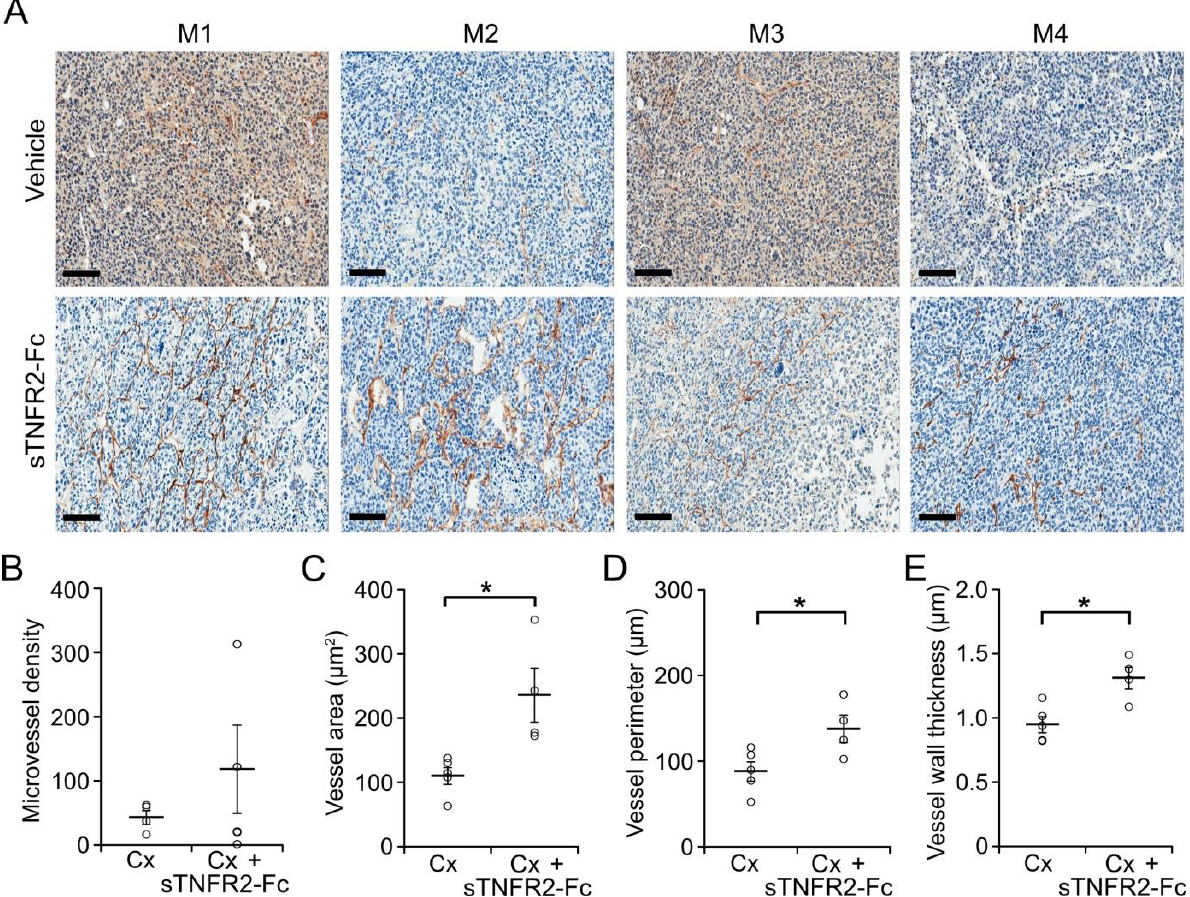
Figure 1. Castration-induced vascular damage is reversed by TNF signaling blockade. ( A ) Repre- sentative sections of CD31 immunoreactivity in Myc-CaP prostate tumors from four mice (M1 – M4) castrated (upper panels) or castrated and treated with sTNFR2-Fc (lower panels). Scale bars are 100 µm. ( B ) Microvessel density (vessels per square millimeter). ( C ) Vessel cross-sectional area, in µm 2 ; ( D ) Vessel perimeter length, in µm; ( E ) Vessel wall thickness, in µm. ( B – E ) Large bars, means of measures from the tumors of five vehicle-treated castrated mice and from four sTNFR2-Fc-treated castrated mice (open circles), small bars = SEM. * p < 0.05.